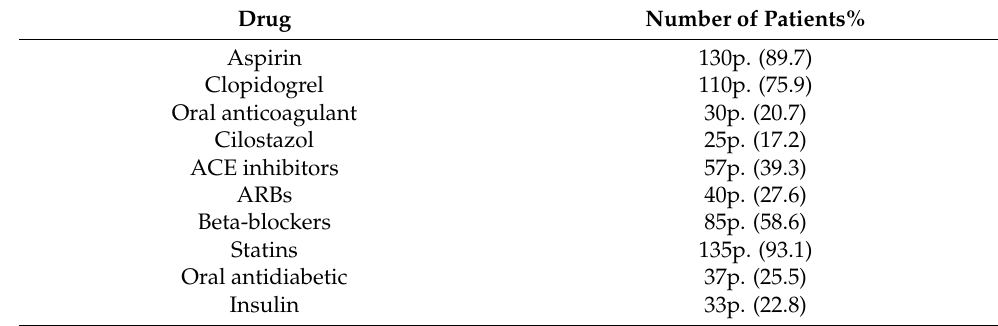
Table 3. Treatment during the hospitalization and after the discharge from the